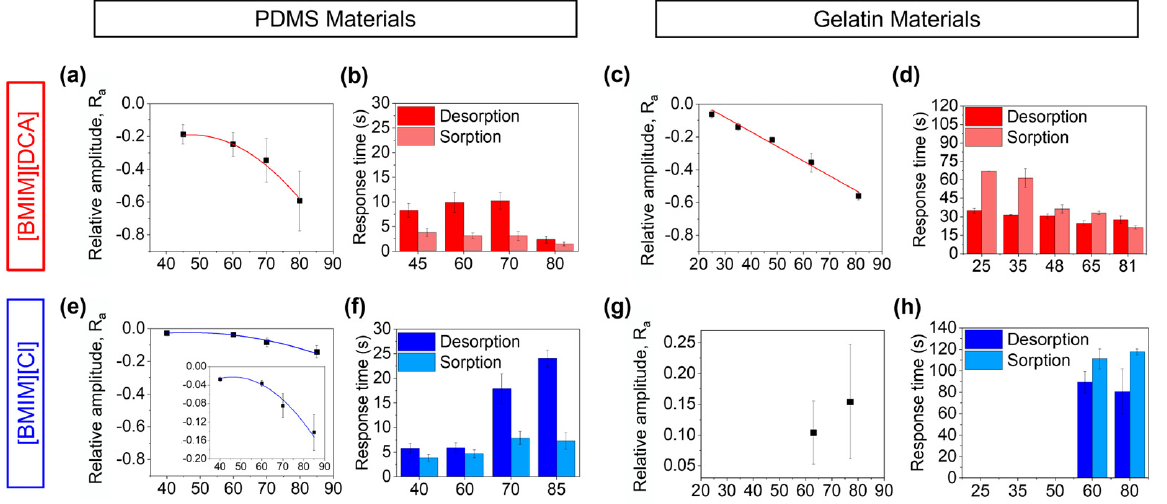
Figure 4. Analysis of the relative amplitude and response time to humidity of hybrid films made with PDMS or gelatin and the ionic liquids [BMIM][DCA] ( a – d ) or [BMIM][Cl] ( e – h ). ( a – h ) Response time of the optical signal of hybrid films as a function of %RH, representing the required time to reach a stable-state response to humidification from 0% to different RH levels (sorption) and to drying from those RH levels to 0% RH (desorption). ( a ) Polynomial fit of the variations of the relative amplitude of the optical response of [BMIM][DCA]-based hybrid films made with PDMS as a function of %RH (optical signal relative amplitude = − 0.0004 × %RH 2 + 0.0421 × %RH − 1.2208, R 2 = 0.99). ( c ) Linear fit of the variations of the relative amplitude of the optical response of [BMIM][DCA]-based hybrid films made with gelatin as a function of %RH (optical signal relative amplitude = − 0.009 × %RH + 0.188, R 2 = 0.98). ( e ) Polynomial fit of the variations of the relative amplitude of the optical response of [BMIM][Cl]-based hybrid films made with PDMS as a function of %RH (optical signal relative amplitude = − 7 × 10 − 5 × %RH2 + 0.0057 × %RH − 0.1475, R 2 = 0.98). ( n = 3 independent replicates of each hybrid film were used to measure the optical responses to humidity).